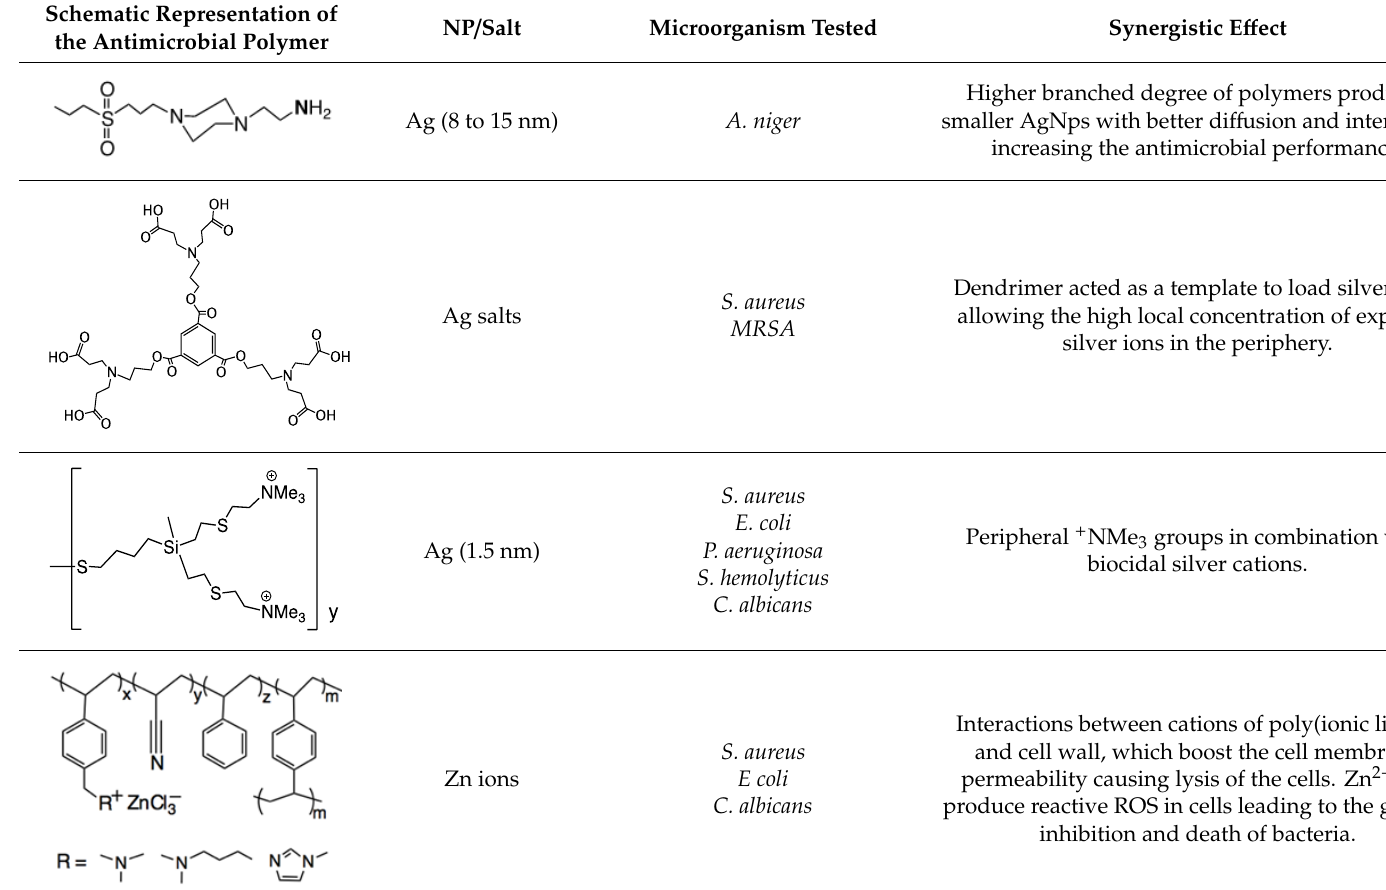
[107] Figure 7. Illustration of the synthetic procedure of AgNPs embedded PTBAM nanofibers. Reproduced with permission from reference [99]. Copyright 2011 ACS.